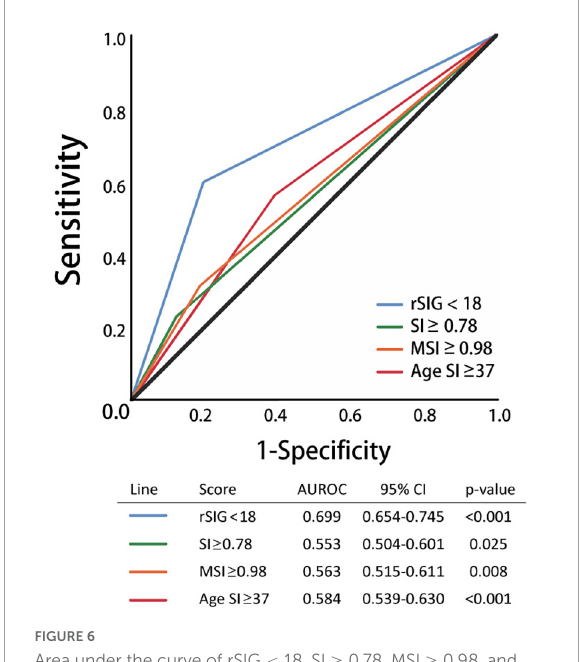
FIGURE6 Area under the curve of rSIG < 18, SI ≥ 0.78, MSI ≥ 0.98, and ASI ≥ 37 for mortality